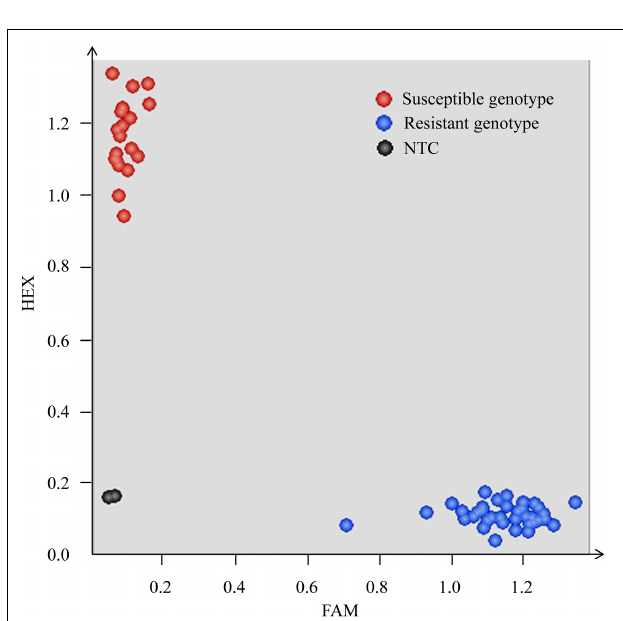
FIGURE 5 | Scatter plots of the RIL population from cross H962R × H962S for the Kompetitive allele-specific PCR (KASP) assay using the Pm5e functional marker Pm5e-KASP. The blue and red dots represent the lines with the disease-resistant and susceptible genotypes, respectively. The non-template control is indicated by the black